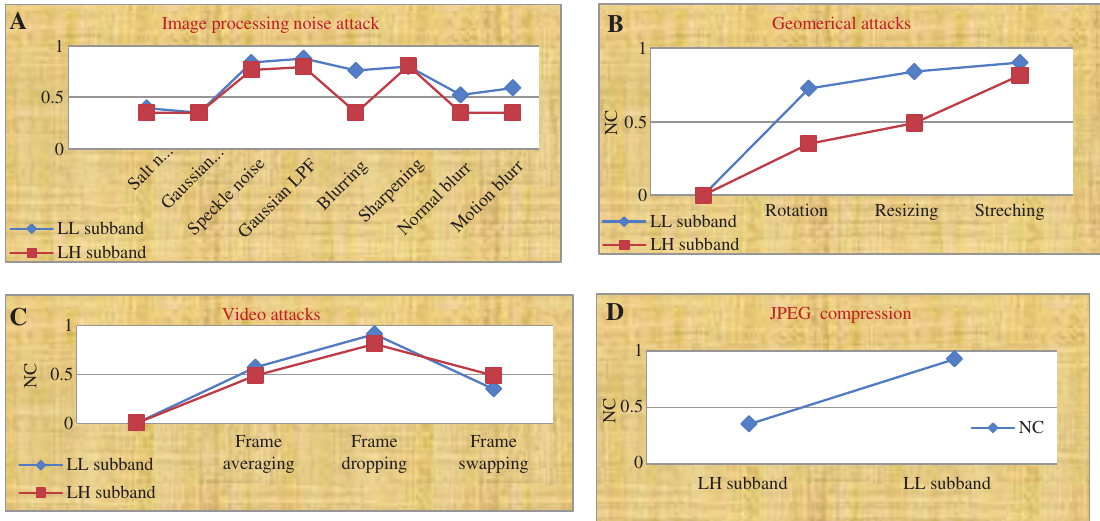
Figure 7: (A–D) Comparative Analysis of Robustness against Different Types of Attack between the LL Subband and the LH Subband Based on Normalized Correlation. (A) Image Processing Attack; (B) Geometrical Attacks; (C) Video Attacks; (D) JPEG